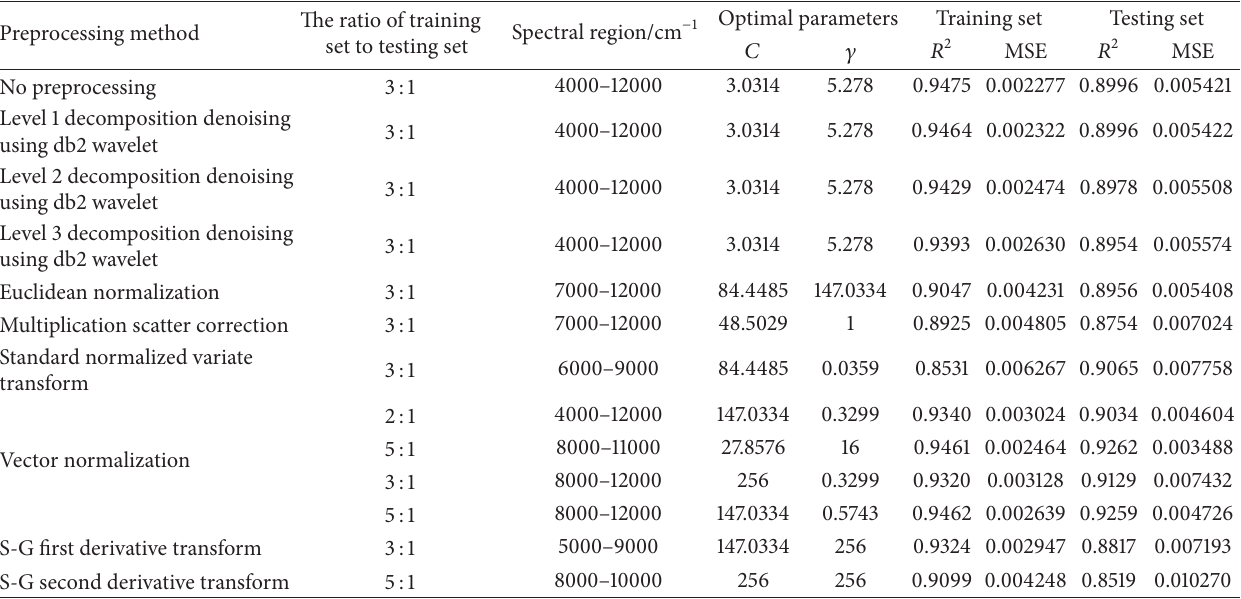
Table 4: The prediction results of the optimal SVR models using different preprocessing methods of the near infrared spectra for quantitative determination of germinability of Puccinia striiformis f. sp. tritici